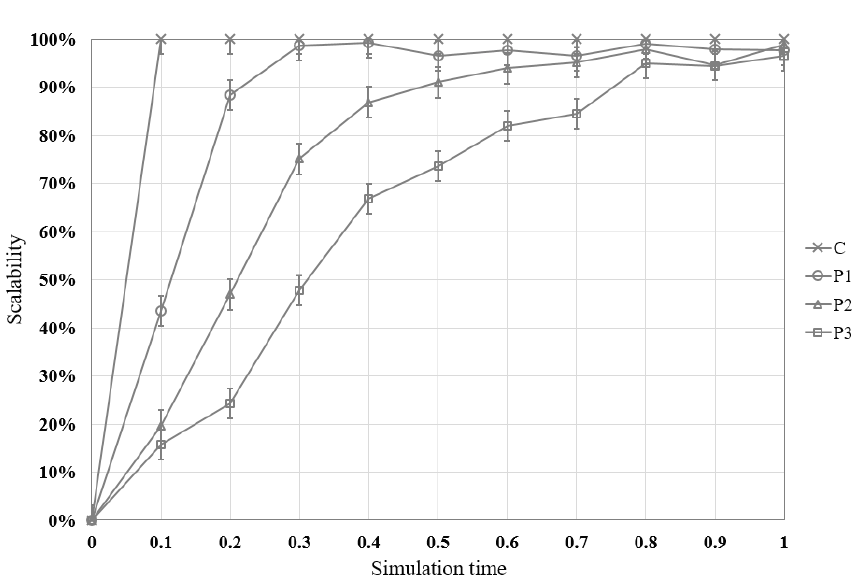
Figure 8. Comparison results of scalability.